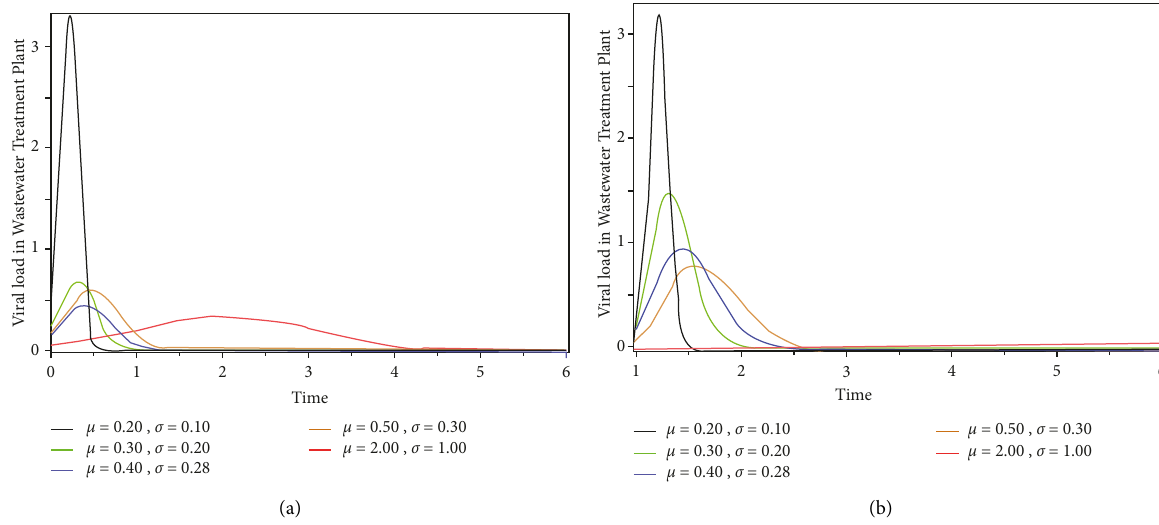
Figure 4: (a) Possible SARS-CoV-2 load in WWTP using the normal model. (b) Possible SARS-CoV-2 load in WWTP using the log-normal model.